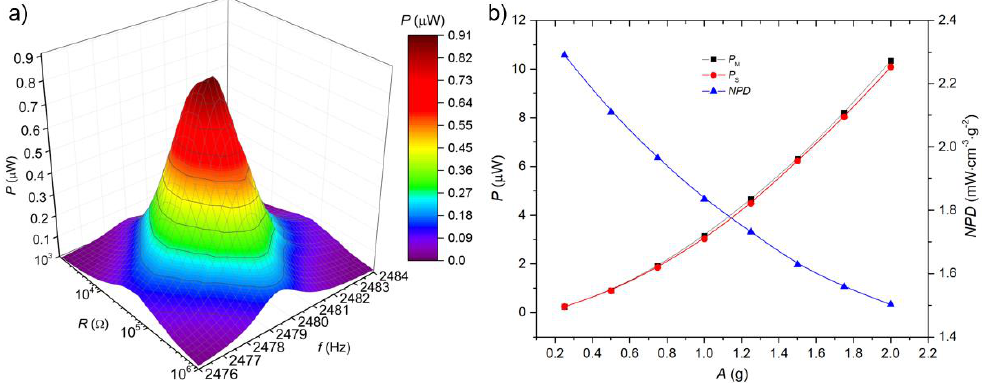
Figure 10. ( a ) Power spectra of measured PEH near f r = 2480 Hz with constant A ≈ 0.5 g, ( b ) dependence of maximum generated P S and P M and calculated value of NPD on A .